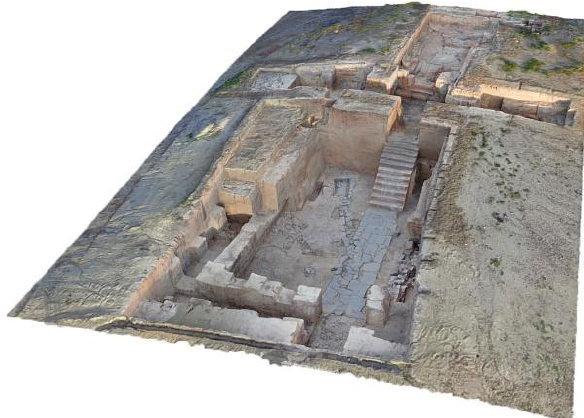
Figure 6. Photogrammetric reconstruction of the site of Casas del Turuñuelo (Guareña, Badajoz) on completion of work on the third campaign of archaeological